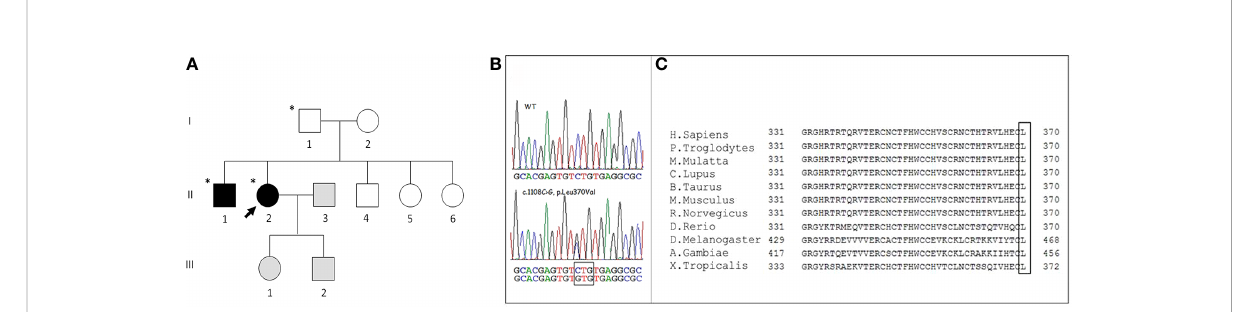
FIGURE 1 (A) Family pedigree. Squares represent men, circles women, black symbols affected family members, white symbols unaffected members, grey symbols members not evaluated; the asterisk identi fi es subjects carrying the WNT1 p. Leu370Val variant. The arrow identi fi es the proband. (B) Representative Sanger sequencing results of a healthy subject and the proband: the sequencing chromatogram of the index patient indicates a heterozygous WNT1 c.1108C>G mutation (nomenclature according to National Center for Biotechnology Information Reference Sequence: NM_005430). (C) Alignment of Wnt1 protein in different vertebrate species. The highly conserved last amino acid (L) of Wnt1 is highlighted in the